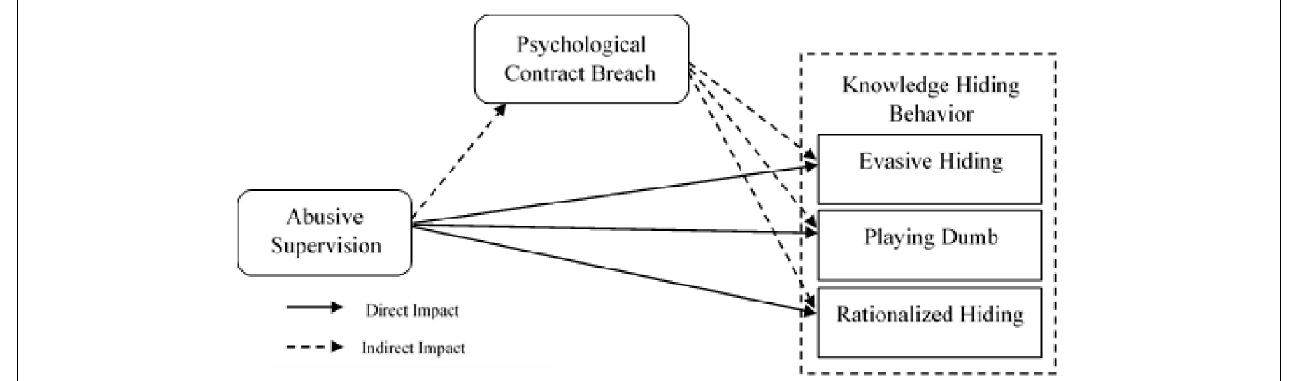
FIGURE 1 | Conceptual